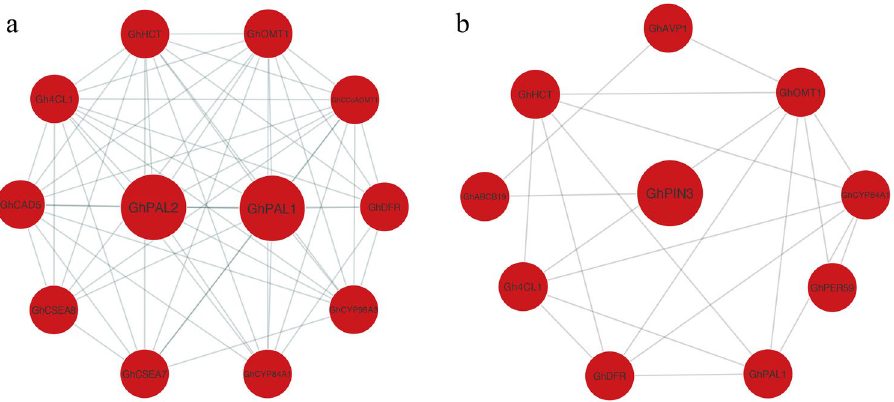
Figure 4. Protein ‐ protein interaction (PPI) network analysis of DAPs. ( a ) The top PPI network using MCODE analysis under ABA treatment. ( b ) The top PPI network under ABAI